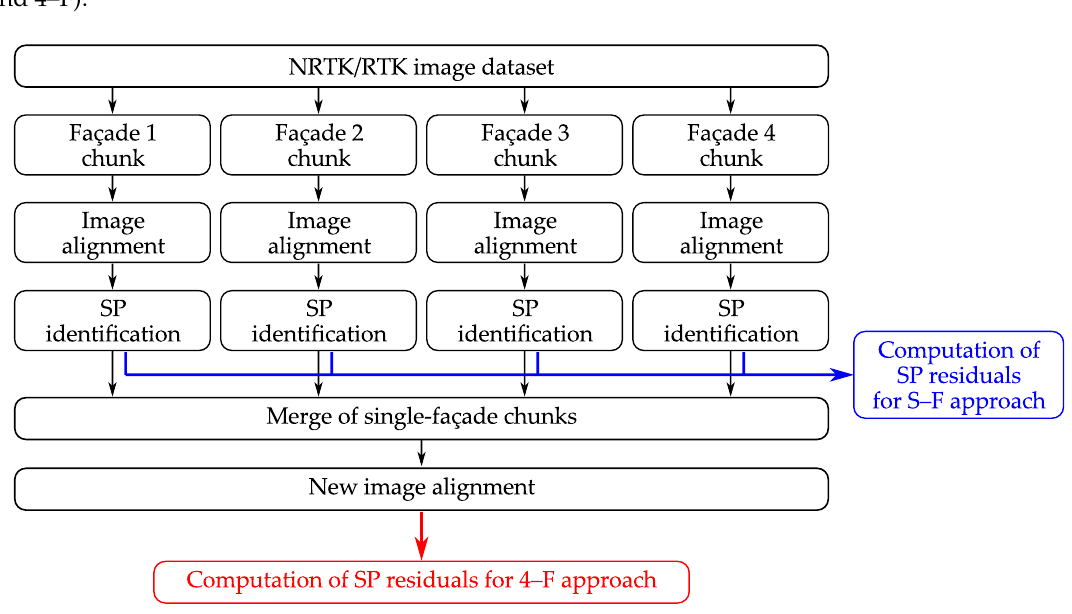
Figure 6. Data processing for Network Real-Time Kinematic (NRTK) and Real-Time Kinematic (RTK) image